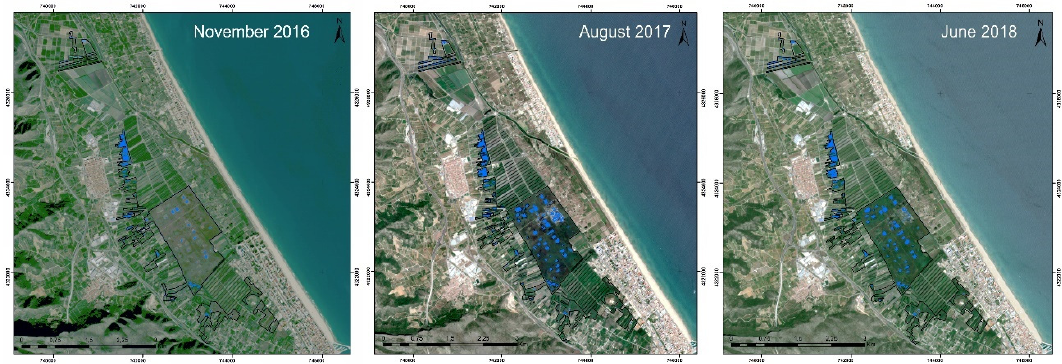
Figure 9. Delimited water bodies with the NDWI index in Safor wetland.